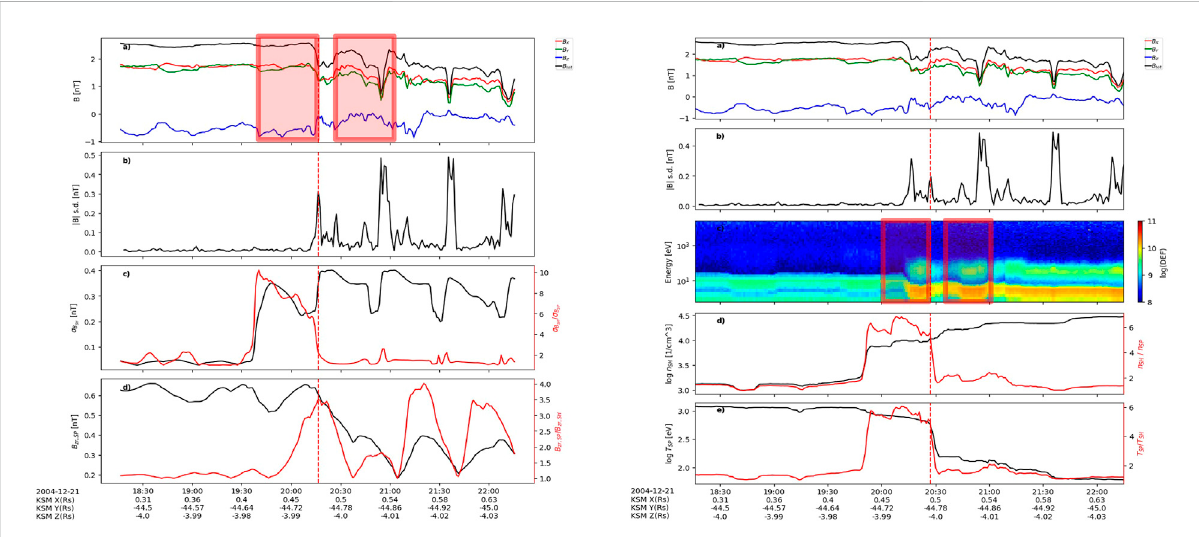
FIGURE 6 (A) ofbothsubplotsshowthemagnetic fi eldcomponentsandmagnitude. (B) ofbothsubplotsshowthestandarddeviationofthemagnetic fi eld magnitude. thresh-mag (left): Threshold method to detect boundary crossings using four magnetic fi eld parameters: B standard deviation in SH [ (C) blackline],theratioofBstandarddeviationbetweenSHandSP[ (C) redline],North-south/radialcomponentofBinSP[ (D) blackline],andtheratioof Bz or Br between SP and SH [ (D) red line]. thresh-caps (right): Threshold method to detect boundary crossings using four density and temperature parameters: log electron density in SH [ (D) black line], the ratio of density between SH and SP [ (D) red line], log temperature in SP [ (E) black line], and the ratio of temperature between SP and SH [ (E) red line]. For both methods, threshold values were acquired using Bayesian